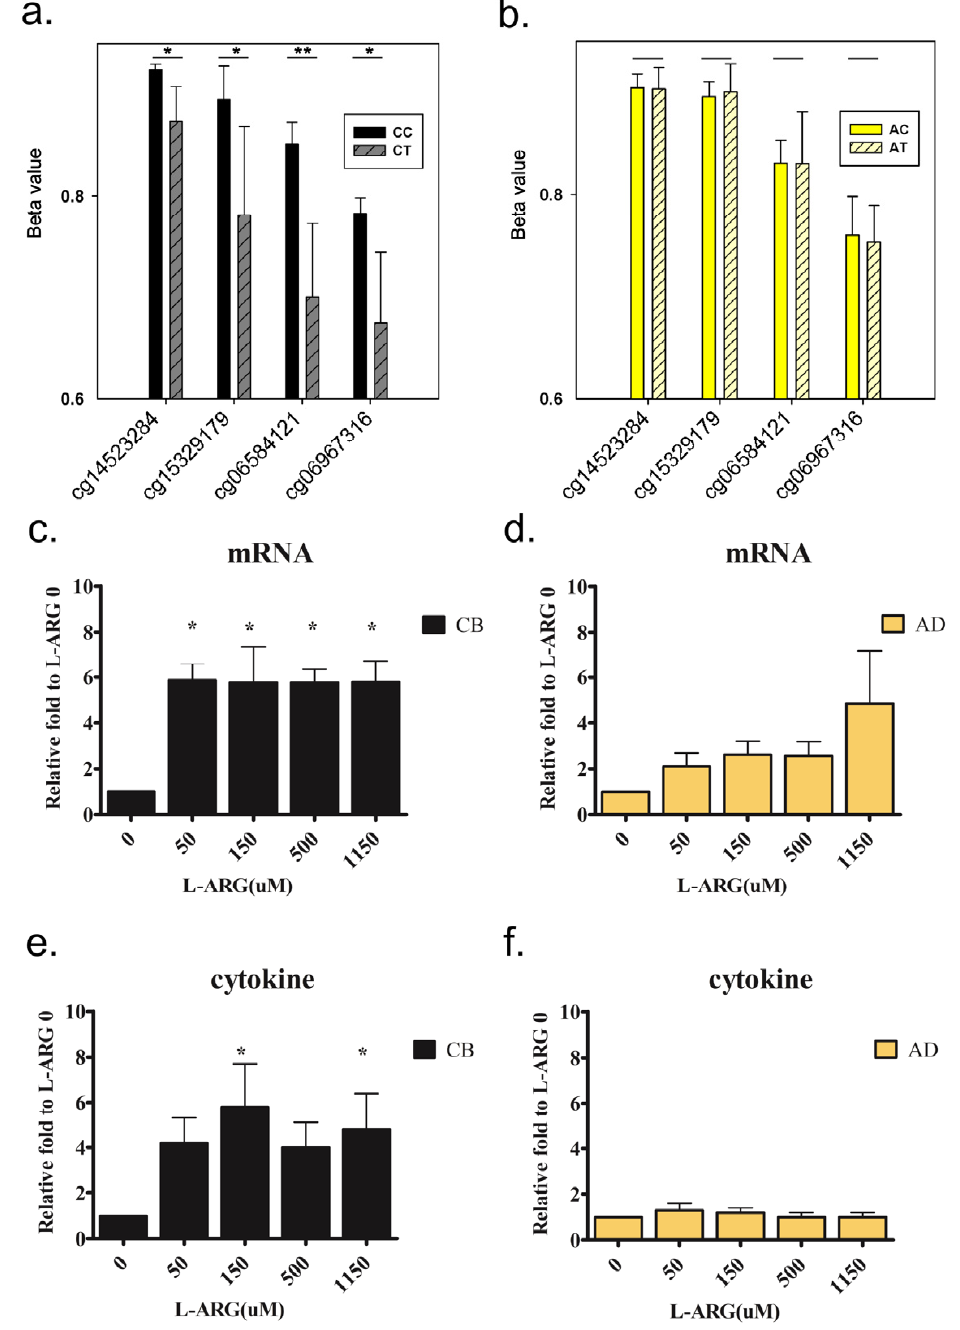
Figure 6. Variations of CpG methylation profiles, mRNA expression, and protein production of IL-13 in cord blood and adult blood after L -arginine treatment. We tested whether the L -arginine treatment affected the CpG methylation profile ( a , b , n = 3, t -test), mRNA expression ( c , d , n = 12, Mann–Whitney U test), and protein production ( e , f , n = 12, Mann–Whitney U test) of IL-13 in cord blood and adult blood. * and ** denoted p -value < 0.05 and 0.01,